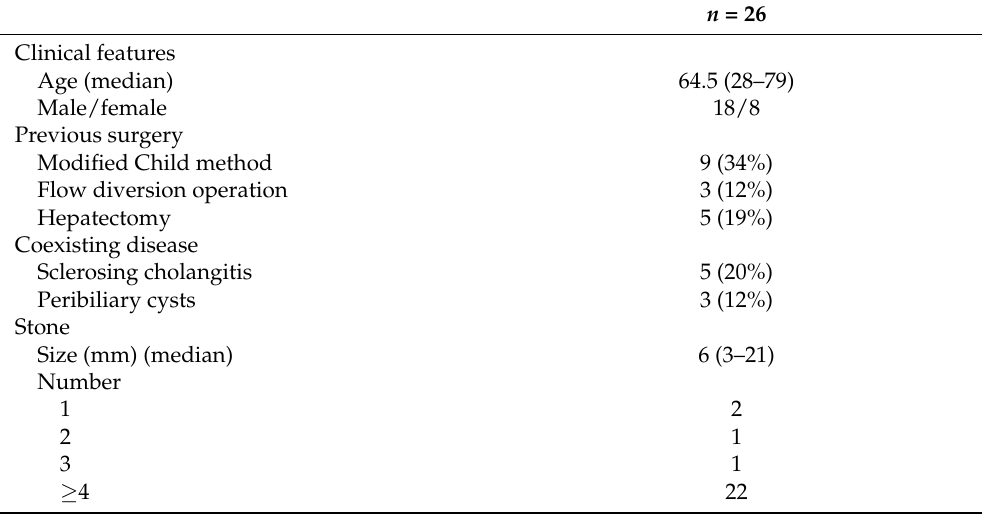
Table 1. Patient characteristics.